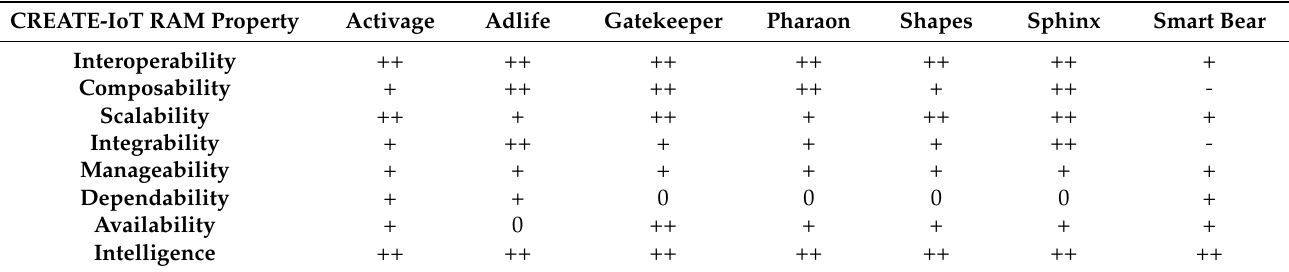
Table 6. Projects’ architectures addressing CREATE-IoT 3D RAM